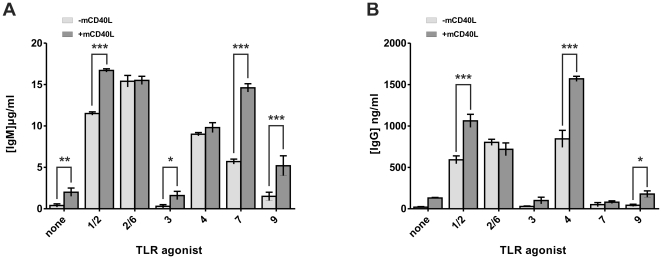
Antibody production in purified B cell culture supernatant after activation by TLR agonists in association with mCD40L.Purified B cells were cultured as described in figure 2 for 6 days. Cell culture supernatants were collected and amounts of IgM (A) and IgG (B) were measured by ELISA as described in Material and Methods. Results are expressed in µg/mL for IgM and ng/mL for IgG and shown as the means+SD of three independent experiments. *p<0.05, **p<0.01, ***p<0.001.